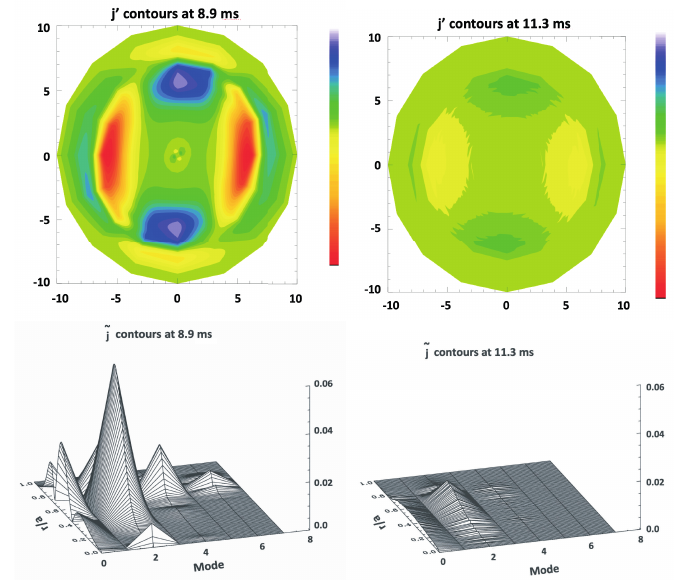
Figure 3. Top : The contour plots of the current density fluctuations ˜ j at t = 8.9 ms corresponding to the saturated level with M S = 0, Pr = 75 ( left ), and at t = 11.3 ms with M S = 10 − 2 , Pr = 1.25 ( right ). Bottom : The corresponding spectra of the current density fluctuations ˜ j as functions of ρ and poloidal mode number m , at t = 8.9 ms ( left ) and t = 11.3 ms ( right ).